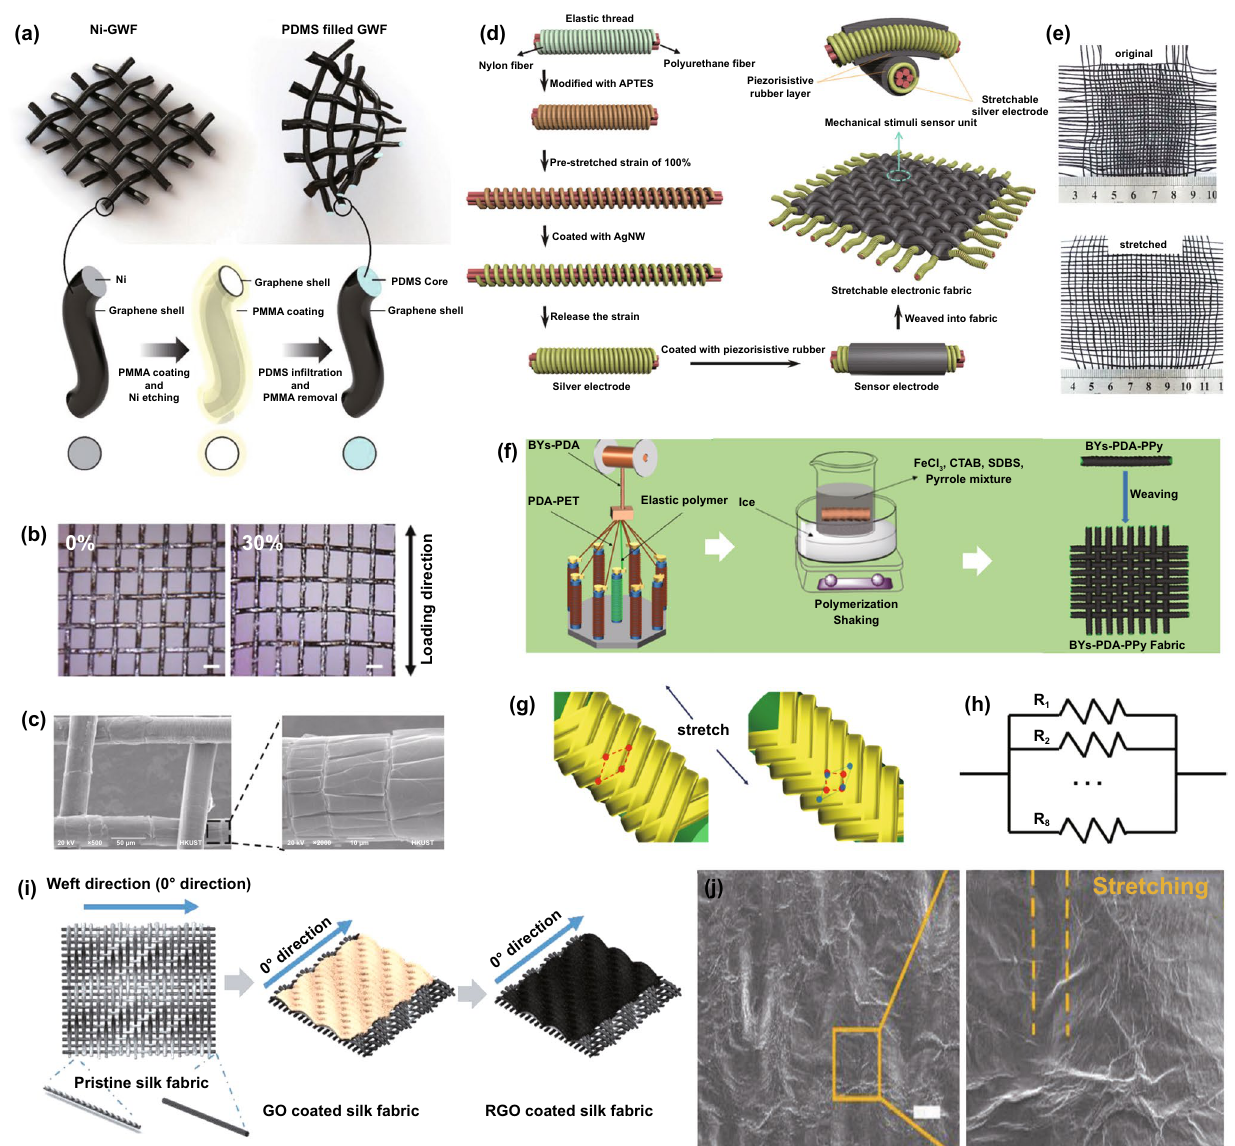
Fig. 7 a A woven-structure strain sensor by depositing graphene on a nickel mesh and replacing the nickel by PDMS, b the surface morpholo- gies of the sensor under 0 and 30% strain respectively, and c the crack formation with applied strain to illustrate the sensing mechanism [176]. Copyright © 2019 American Chemical Society. d Illustration of a woven strain sensor through weaving Ag NWs and piezoresistive rubber- coated yarns into a fabric, and e the images of the fabric sensors in the original and stretching state [185]. Copyright © 2016 Wiley–VCH. f Fabrication of a strain sensor by weaving conductive polymer-modified yarn into a plain fabric, g the illustration of the yarn without and with stretching, and h the resistance model of the sensor showing the sensing mechanism [175]. Copyright © 2019 American Chemical Society. i The process of coating graphene on the surface on a woven silk fabric as a strain sensor, and j crack formation on the graphene layer to show the mechanism of the sensor [177]. Copyright © 2020